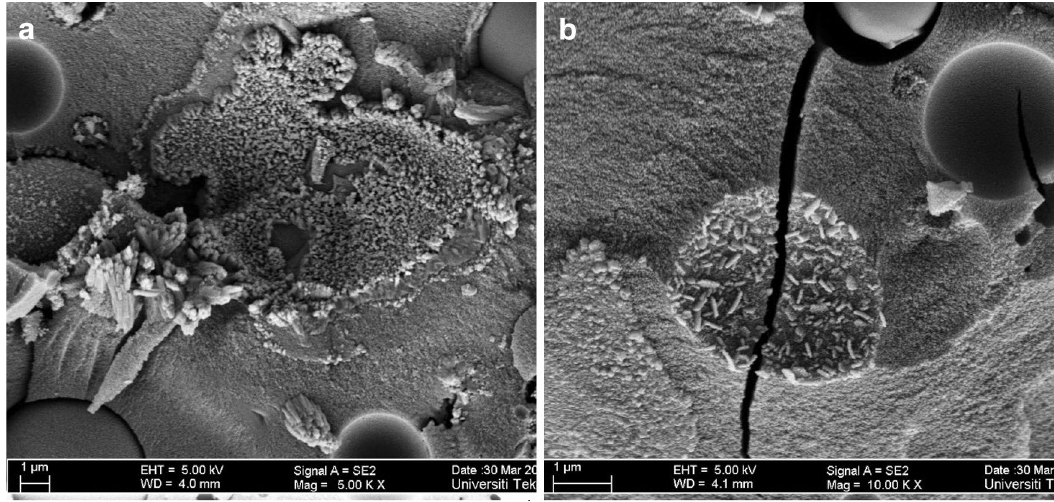
Fig. 2 SEM images after wet supercritical CO 2 exposure a 72GC60w, b zeolite Na-P1 and CaCO 3 formed in the surface of concave